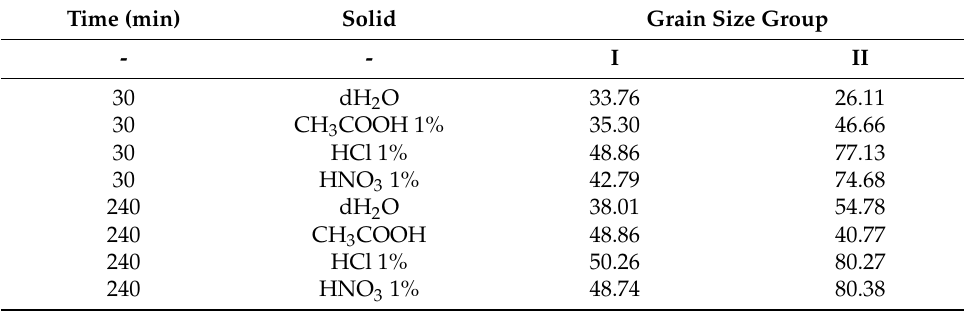
Table 4. Percentage change in ash content in corn I and II (%).